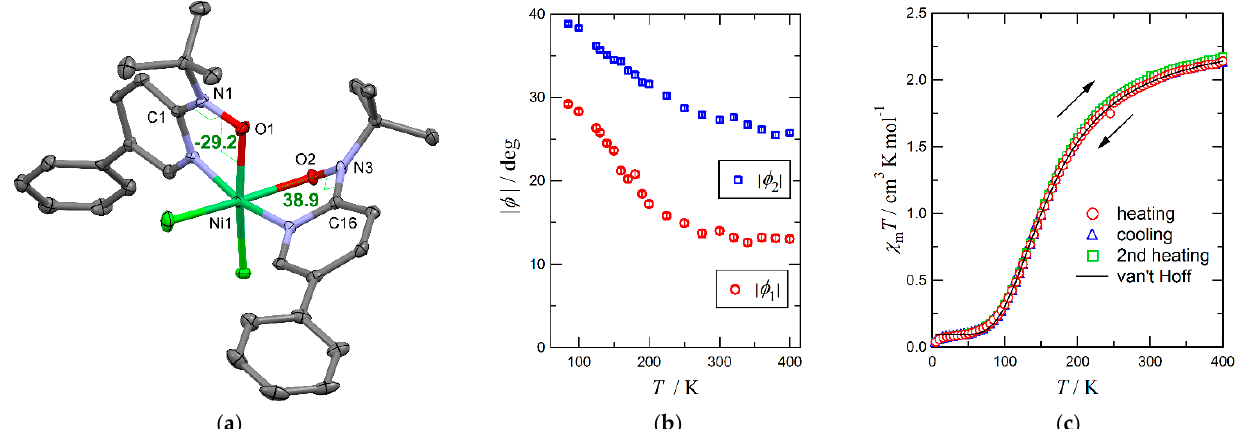
Figure 9. ( a ) X-ray crystal structures of [Ni(phpyNO) 2 Cl 2 ] measured at 85 K. Thermal ellipsoids are drawn at the 50% probability level. Hydrogen atoms are omitted. Selected atomic numbering and torsion angles ( φ (Ni–O–N-C sp 2 )) are indi- cated. ( b ) Temperature dependence of torsion angles (| φ |) and ( c ) temperature dependence of χ m T for [Ni(phpyNO) 2 Cl 2 ]. Adapted with permission from [103], published by the American Chemical Society, 2018.